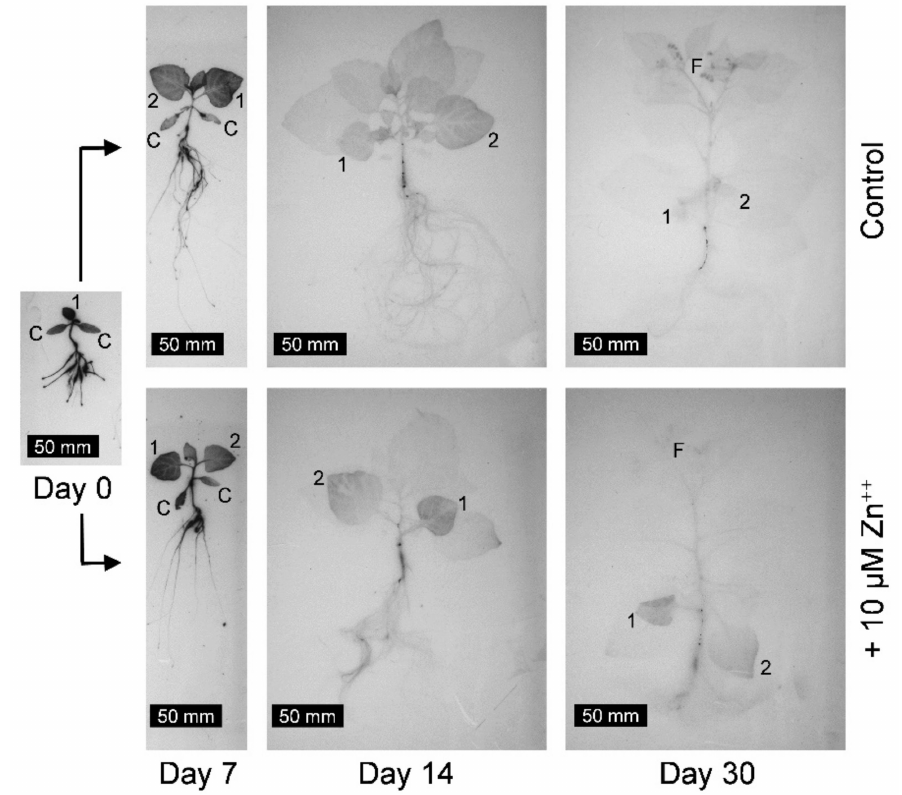
Figure 4. Autoradiographs of plants labeled for 1 d with 65 Zn before day 0 and then incubated for 7, 14, or 30 d on standard medium without (Control) or with additional zinc ( + 10 µ M Zn ++ ). Cotyledons (C), leaf 1 (1), leaf 2 (2), and flowers / fruits (F) are